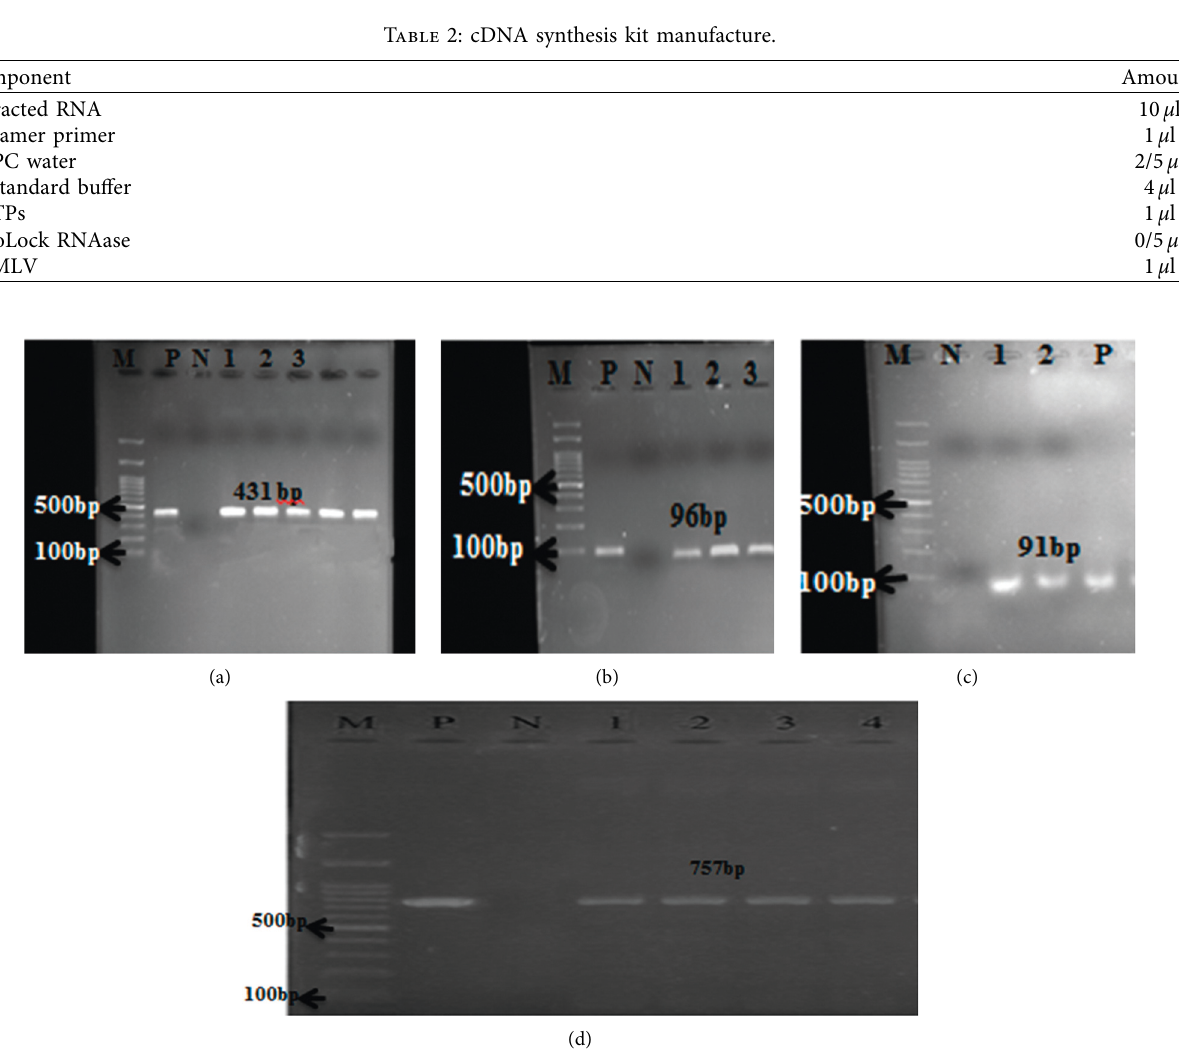
Figure 1: Results of gel electrophoresis related to PCR amplification of various genes in Streptococcus mutans strains, (a) gtfD (431bp), (b) gtfB (96 bp), (c) gtfC (91bp), and (d) 16srDNA gene of Lactobacillus (757bp), M:Marker 100bp, (P) Positive Control for Streptococcus mutans ATCC35866, and Positive Control for Lactobacillus brevis ATCC 436. (N) Negative Control (D.W, gene primers, Mastermix), Numbers: The samples contained the